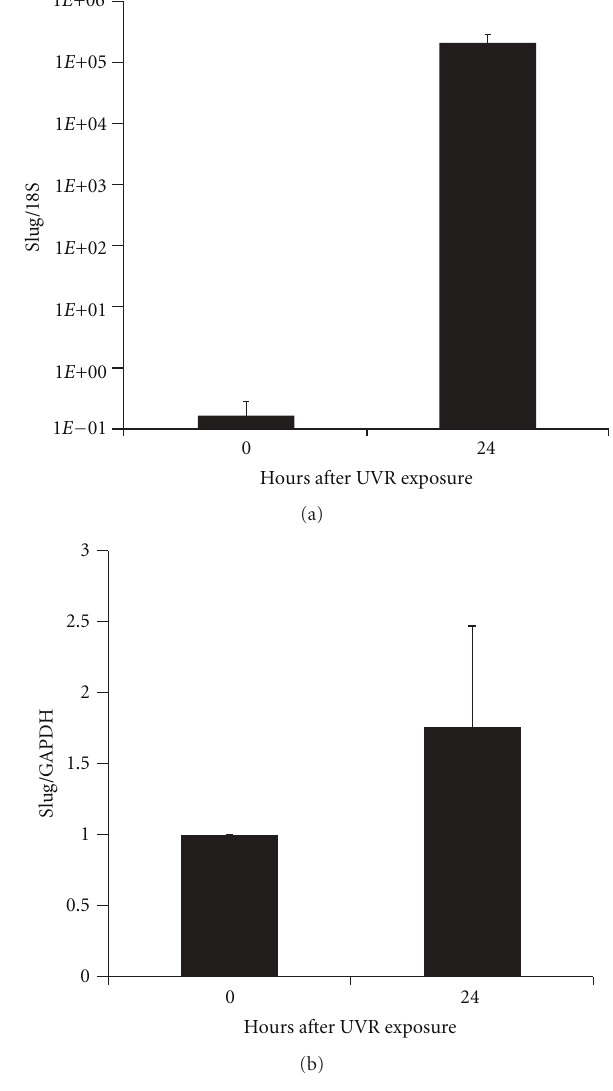
Figure 1: UVR induction of Slug 24 hours following a dose of 300J/m 2 UVR. (a) Slug mRNA levels were determined by RT- QPCR in two independent assays, each performed in triplicate. Bars represent the standard error of all six values. (b) Slug protein levels were determined by Western blotting followed by densitometry in three independent assays. Bars represent the standard